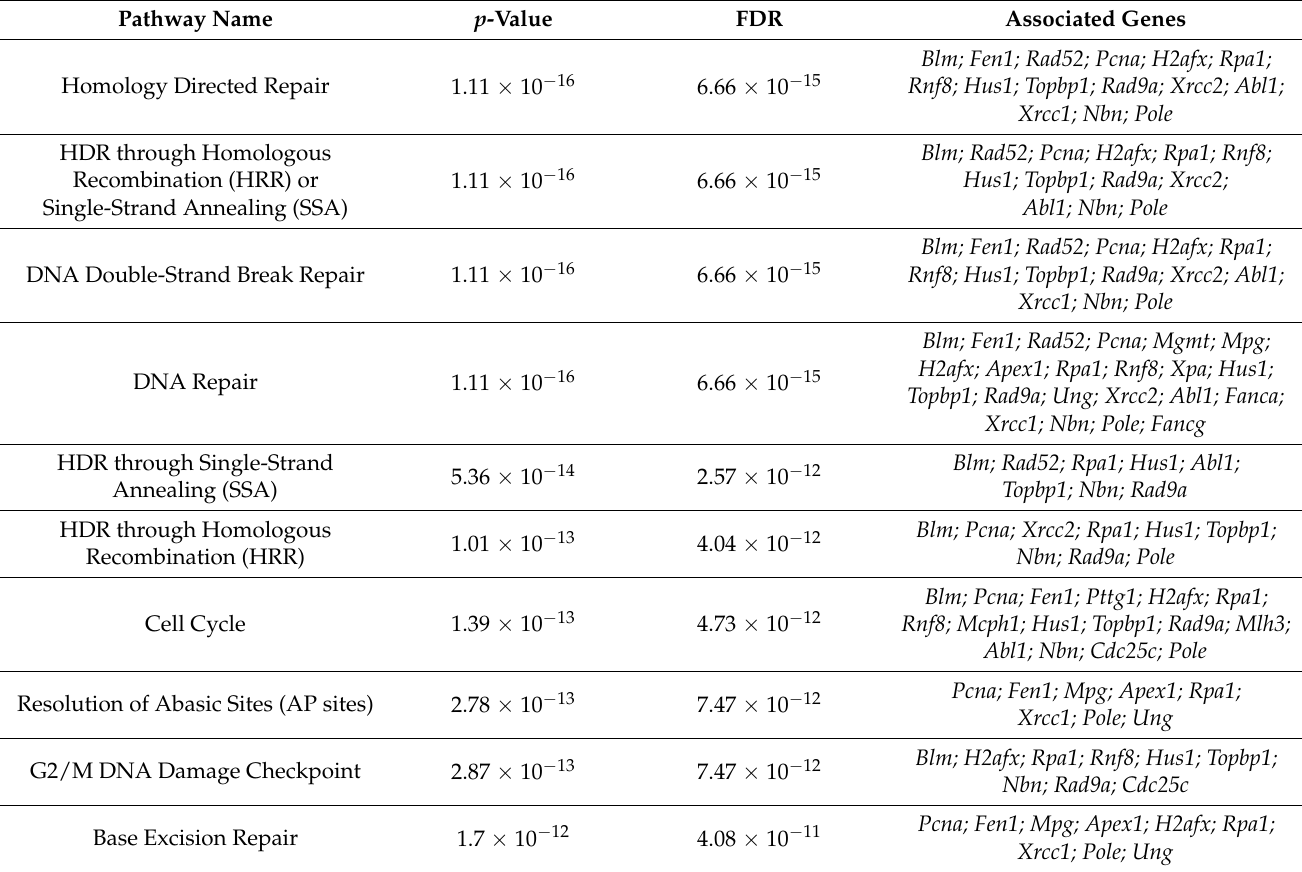
Table 2. Most enriched processes by deregulated genes in cells that overexpress